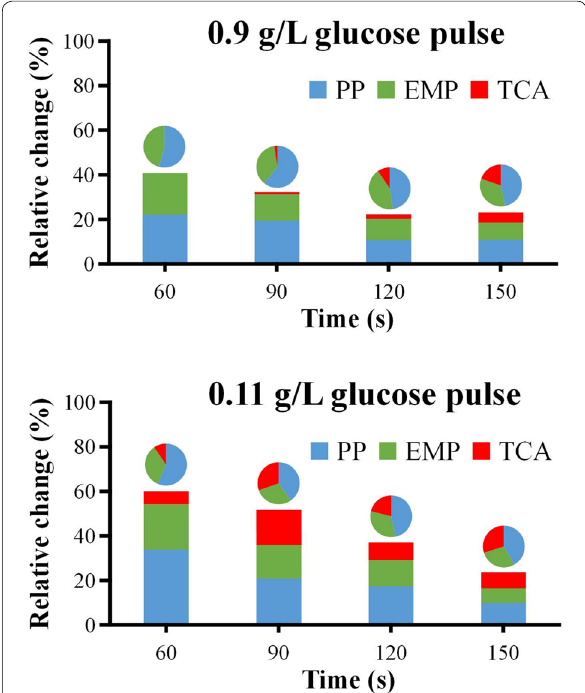
Fig. 7 Carbon accumulation in the central carbon metabolism metabolites after the pulses. The bar chart shows the relative amount of carbons accumulated in the central carbon metabolism assimilated from glucose. The pie chart above each bar shows percentages of carbons accumulated in EMP, PP, TCA pathway intermediates, respectively